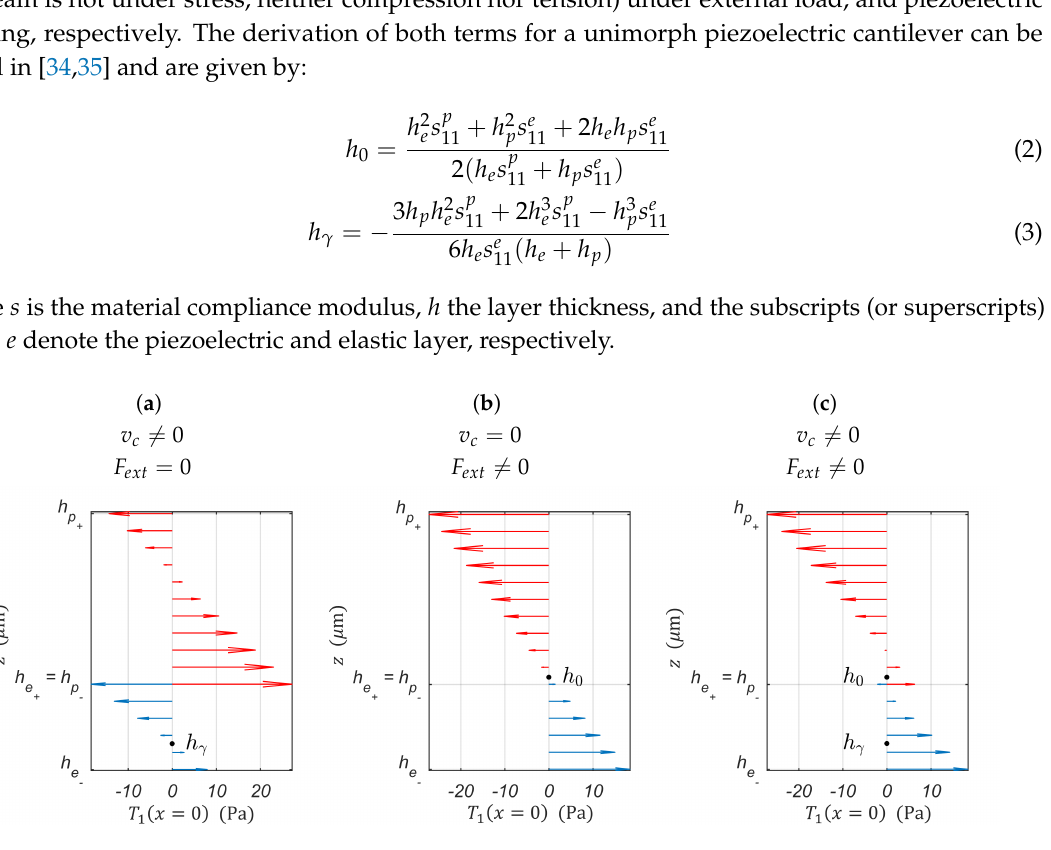
= 4.67 × 10 − 12 m 2 e